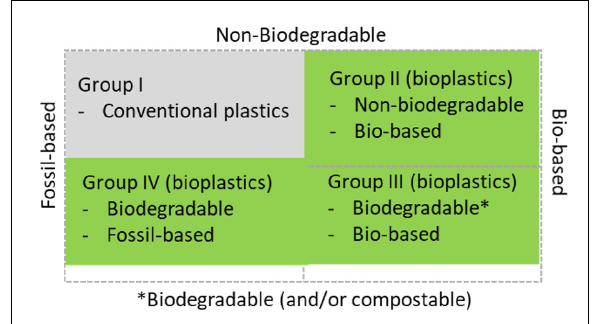
Figure 1: Basic classification of plastics and bioplastics (adapted from Jariyasakoolroj et al. 2 ).